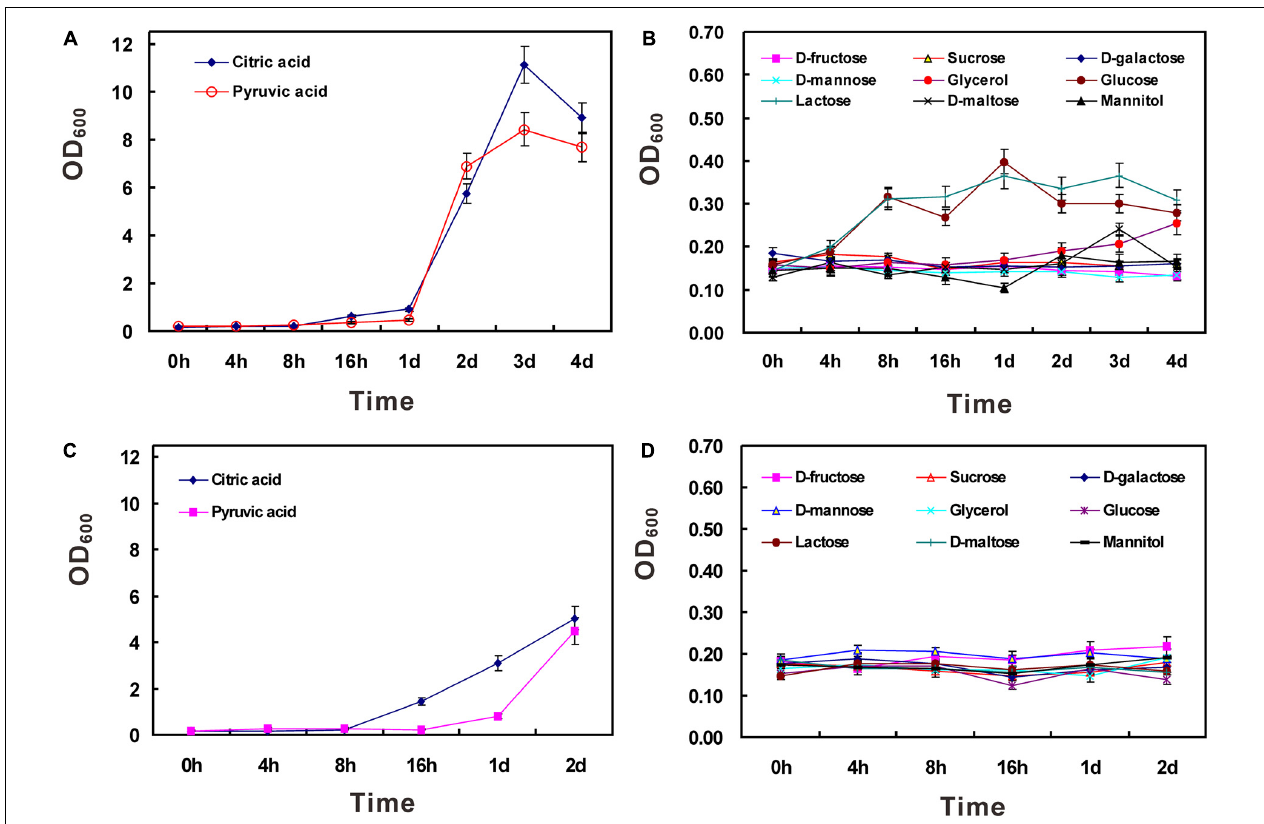
FIGURE 2 | Utilization of carbon sources in strain HZ01. The incubation was performed using medium A supplemented with single carbon source at the concentration of 40 (A,B) and 20 g/L (C,D) , respectively. Data are presented as mean ± standard deviation (SD) involving triplicate assays. OD 600 , optical density at 600 nm; h, hour; d,